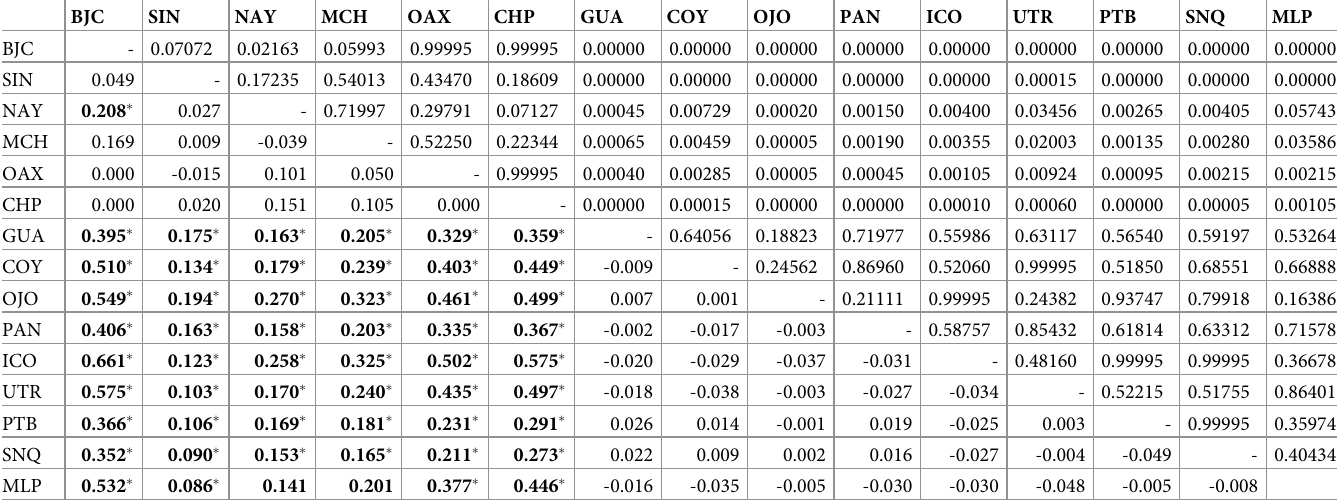
pling sites of the ETP show this same pattern of differentiation (Figs 4A and S1). Two groups were revealed by the STRUCTURE cluster analysis (K = 2), with Costa Rica and Panama Table 2. Pairwise θ ST values and exact test of sample differentiation of the mitochondrial control region for Sphyrna lewini individuals in the Eastern Tropical